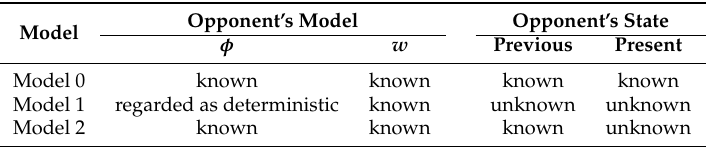
Table 2. Available information about the